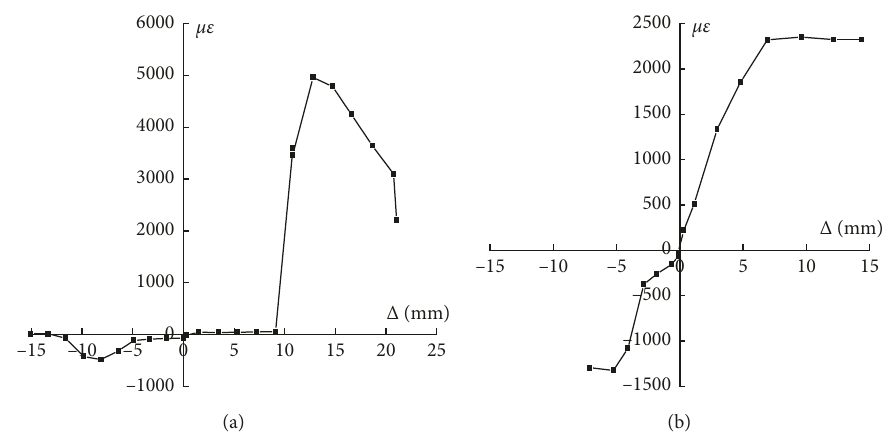
Figure 16: Longitudinal reinforcement root strain diagram: (a) A2 and (b) Table 7: Average strength and design value of compressive strength and shear strength of new energy-saving block masonry (MPa). Strength category